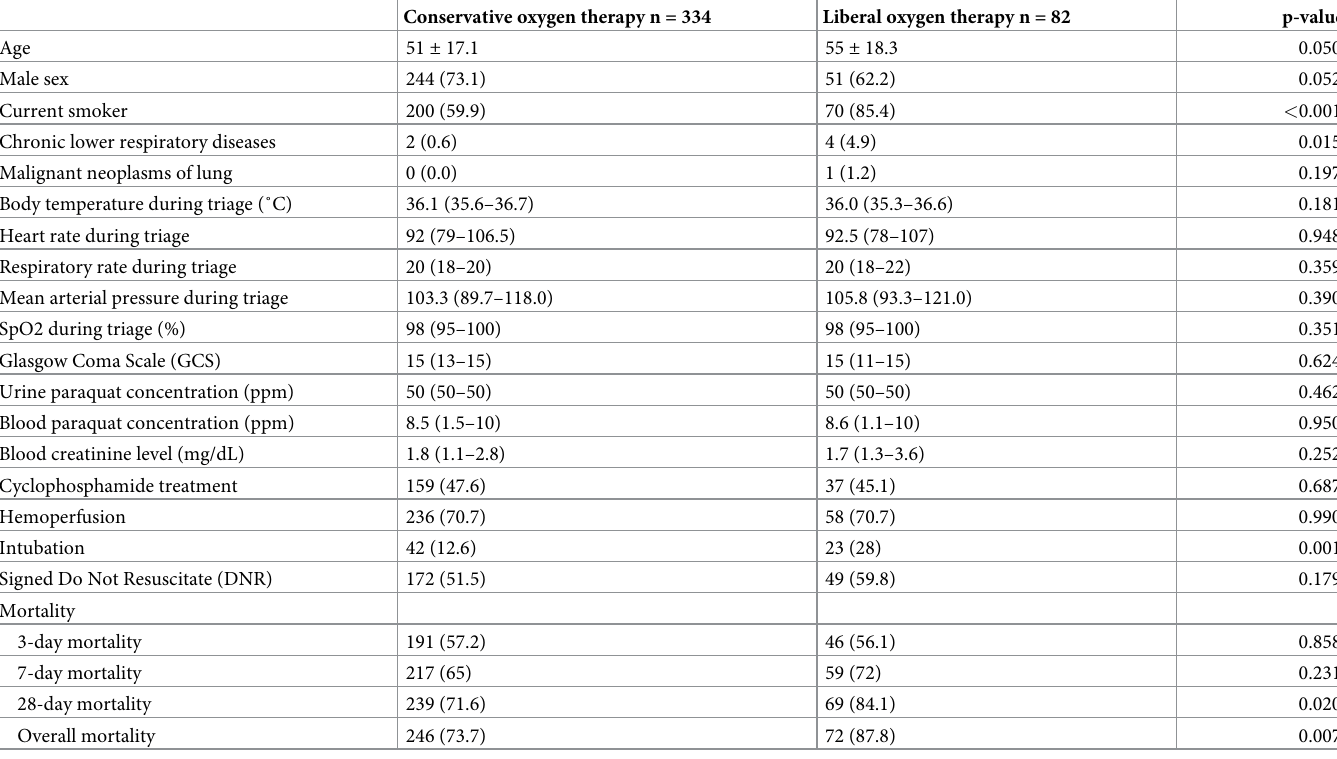
Table 1. Clinical characteristics of patients with paraquat poisoning who received conservative and liberal oxygen therapy (N = 416).